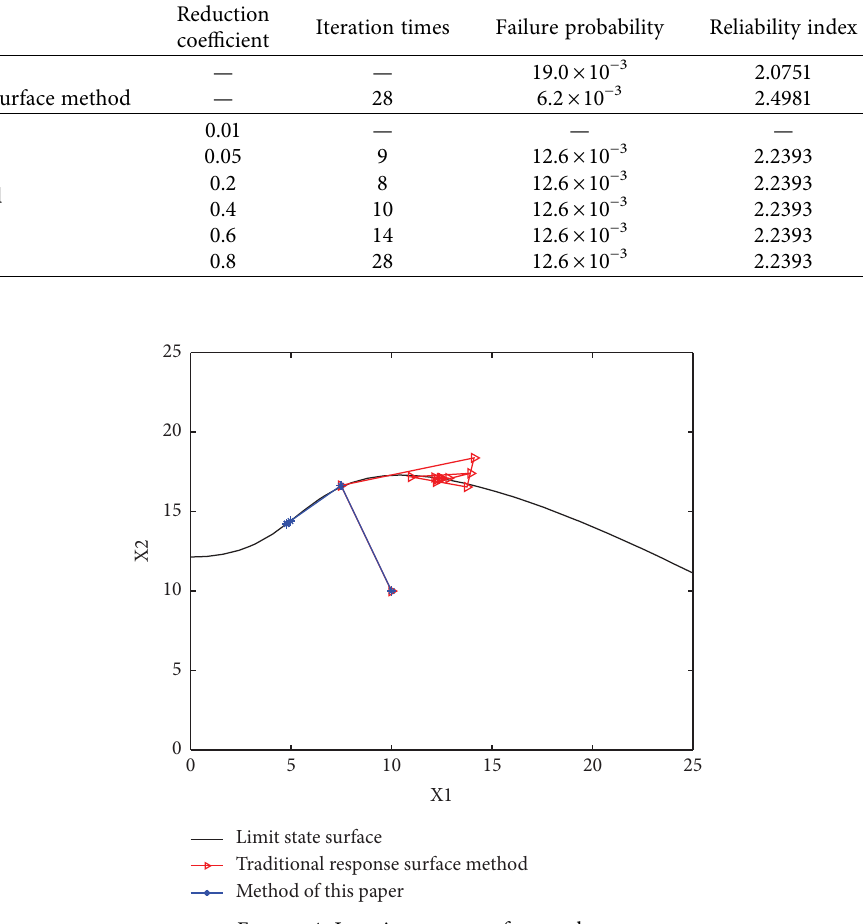
Table 1: Calculation results of example 1.